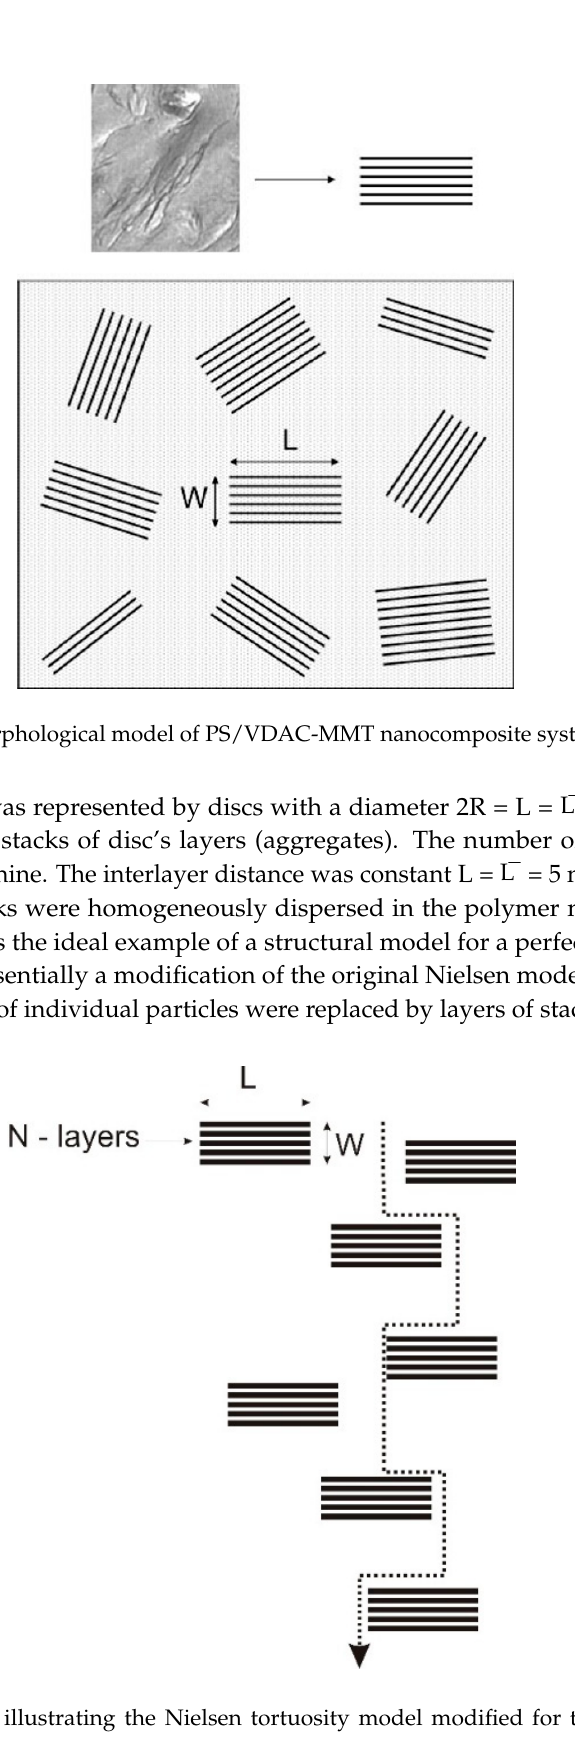
Figure 10. The sketch illustrating the Nielsen tortuosity model modified for the nanocomposite structure consisting of oriented layer stacks homogeneously dispersed in the polymer matrix [113].